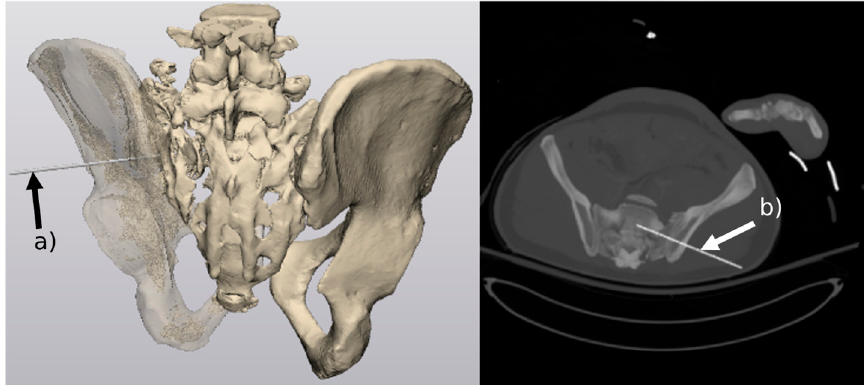
Figure 3. (a ) placement of the guide in 3-matic, ( b ) maximum intensity projection (MIP) of 30 CT slices displaying the location of the guide and its insertion depth.